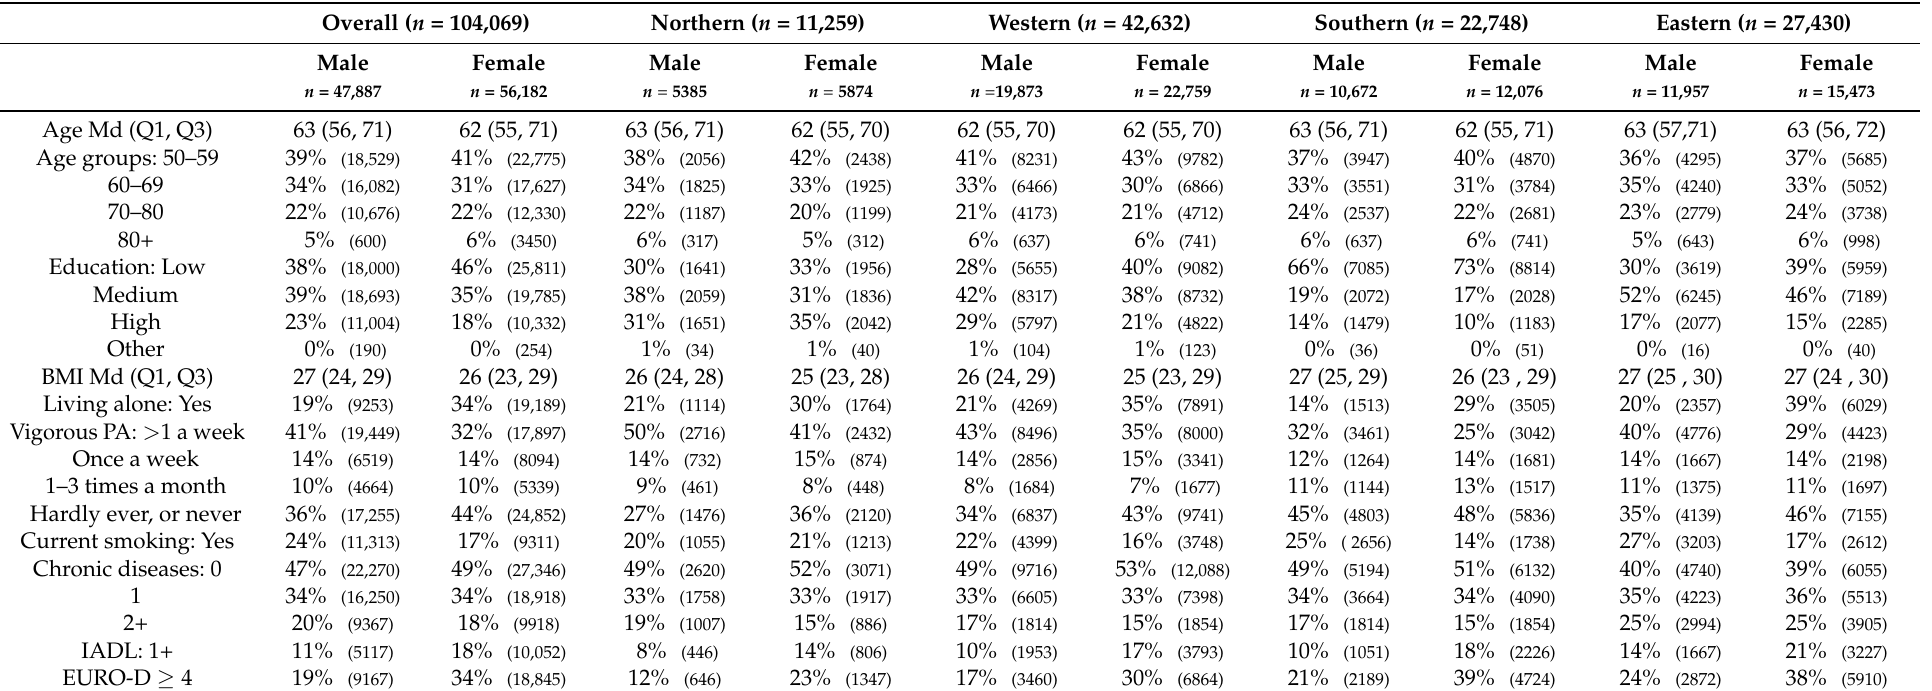
Table 2. Descriptive statistics ( n = 104,069). Md (Q1, Q3) represent the median, lower quartile and the upper quartile for continuous variables. Numbers after percentages are frequencies. Countries were categorized into four regions: Northern Europe (Denmark and Sweden), Western Europe (Austria, Germany, France, the Netherlands, Switzerland, Belgium, Ireland and Luxembourg), Southern Europe (Spain, Italy, Greece and Portugal) and Eastern Europe (Czech Republic, Poland, Hungary, Slovenia, Estonia and Croatia). PA: Physical activity, IADL: Instrumental activities of everyday